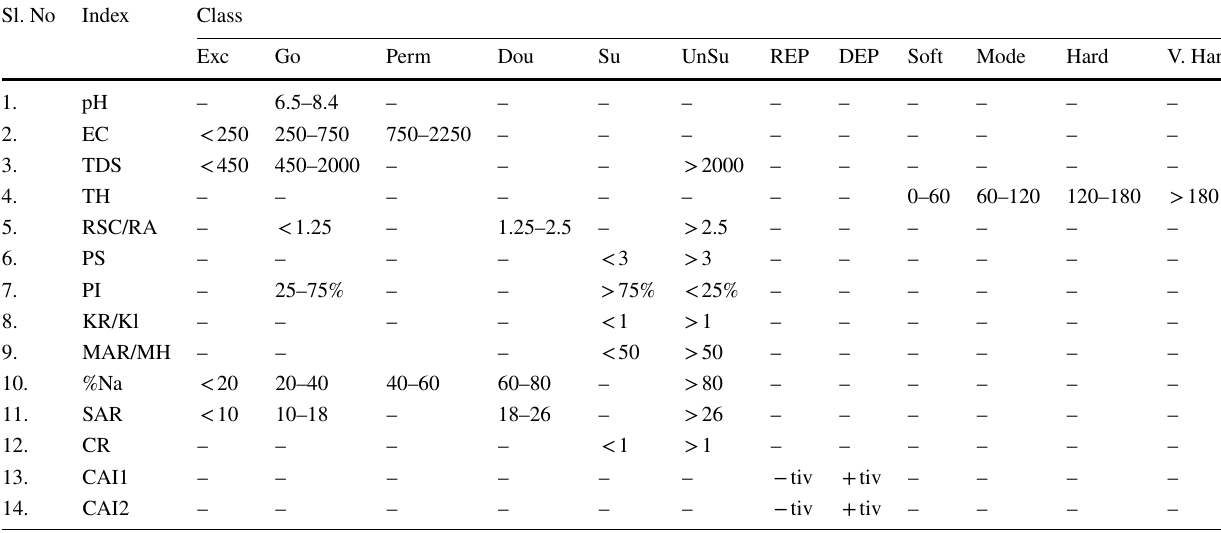
Table 4 Classification of irrigation water suitability based on Na%, SAR, MH, KR RSC, and TDS (Kelley 1940; Wilcox 1948; Thorne 1954; Todd and Mays 1980; United States Environmental Protection Agency